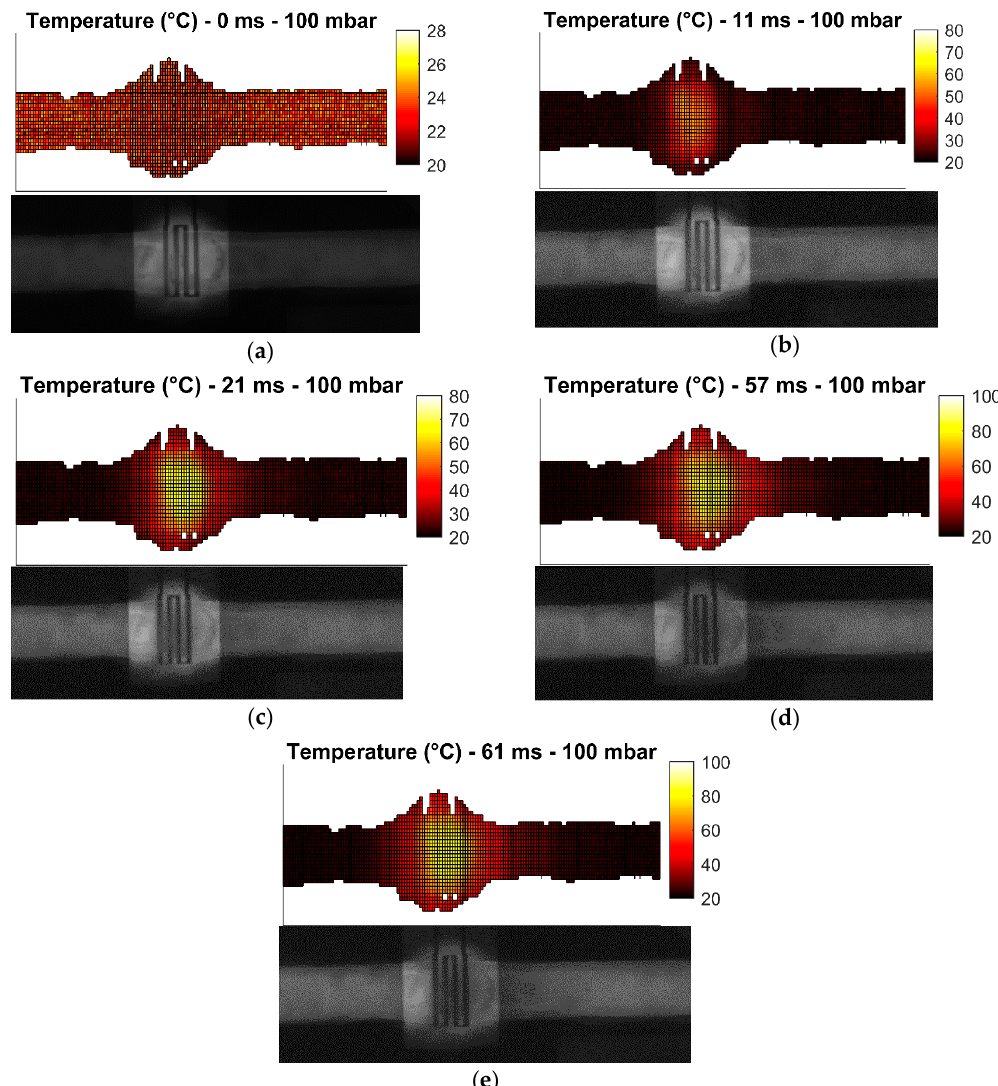
heating started.